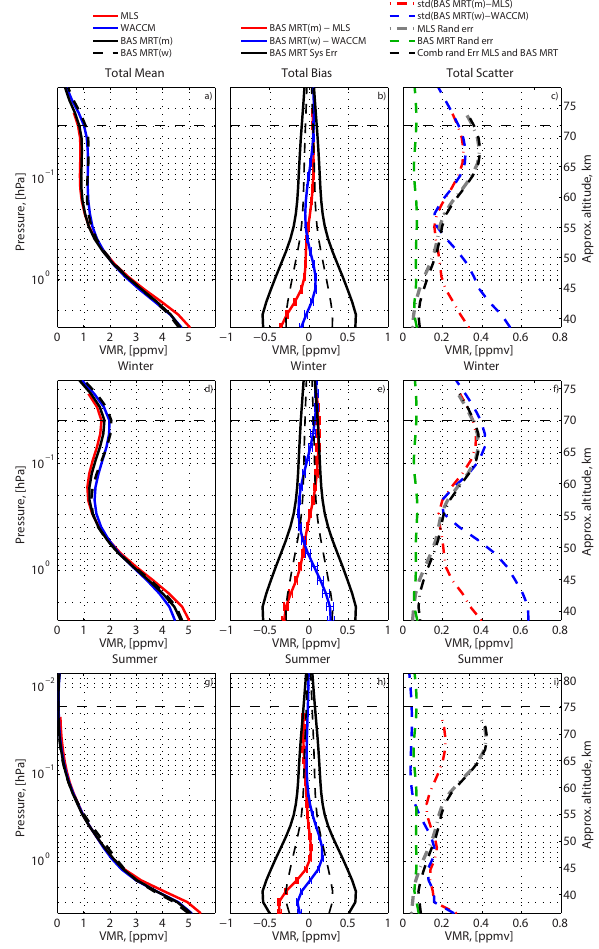
Figure 9. Intercomparison between BAS-MRT, MLS and SD- WACCM using co-incident profiles; (m) labels MLS and (w) labels SD-WACCM: (a , b and c) overall comparison from available co- incident data. (d, e and f) Comparison from summer time (yellow area in Figs. 6 and 7). (g , h and i) Comparison from winter time (grey area in Figs. 6 and 7). Left panels: mean of midnight profiles. Middle panels: the bias with the 1- σ of the standard error of the bias. The black solid (dashed) line is the ± 2- σ ( ± 1- σ ) of the total systematic error of BAS-MRT. Right panels: standard deviation of the bias between the co-incident profiles of BAS-MRT to MLS and SD-WACCM. The combined and individual random errors of MLS and BAS-MRT for midnight values are also